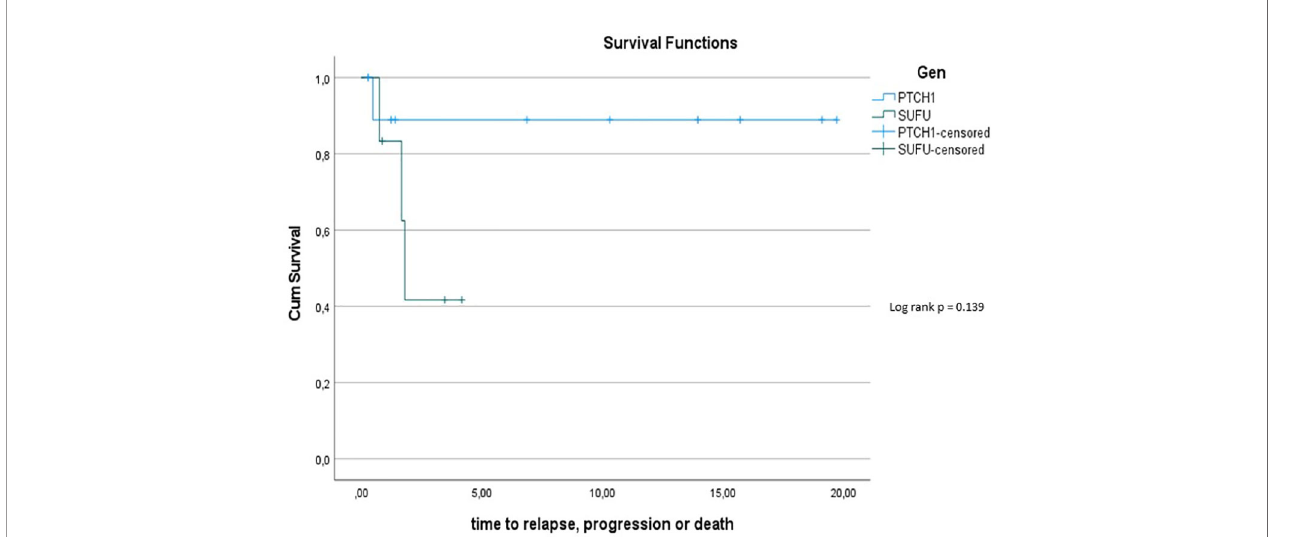
FIGURE 6 | Kaplan-Meier plot for PFs for all patients depending on mutational status (blue = PTCH1 mutated patients; green = SUFU mutated